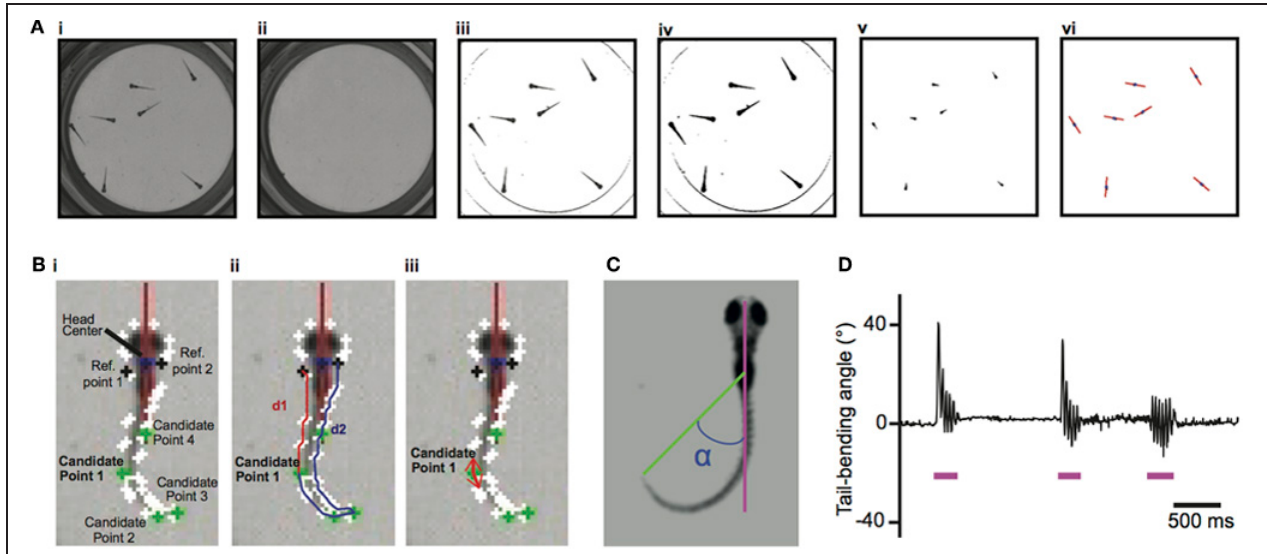
FIGURE 1 | Image processing for tracking of larvae’s core positions and larvae’s tail and detection of movements based on the tail-bending angle. (A) Tracking of the larvae’s core positions. (Ai) Initial image. (Aii) Background image. (Aiii) Image with background subtracted. (Aiv) Binary image. (Av) Eroded image. (Avi) For each larva, identification of the core (blue dot) and heading direction (red axis). (B) . Identifying the tip of the tail. (Bi) The head center is located at the boundary of the head and trunk. Candidate Point 1–4 along the tail are the four points of the